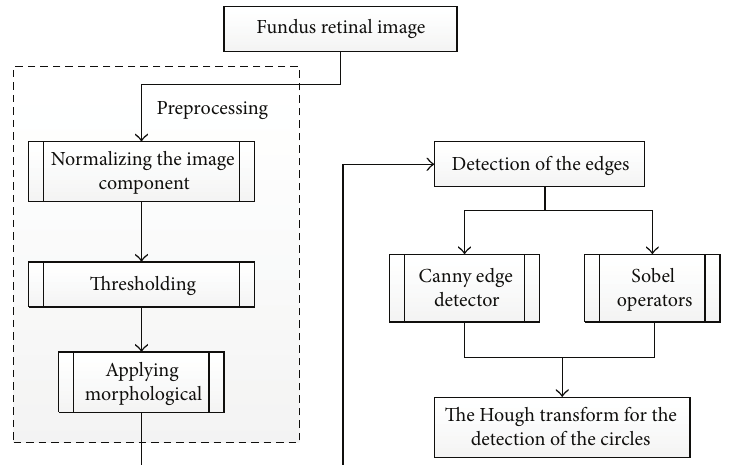
Figure 17: Flowchart for algorithm proposed in [30].